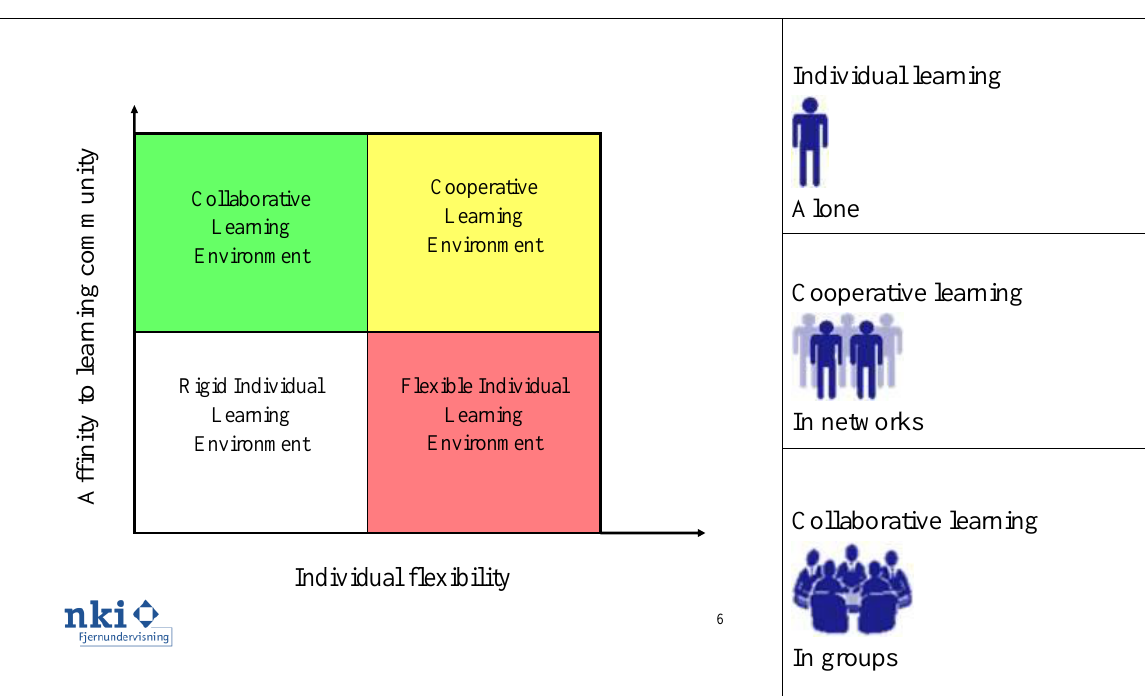
Figure 1. Individual, cooperative, and collaborative learning